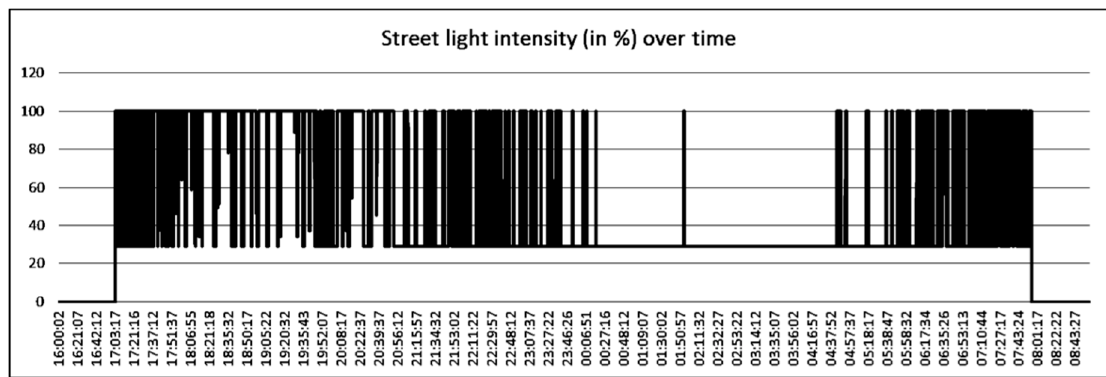
Figure 12. Luminaire intensity level variation during one night.